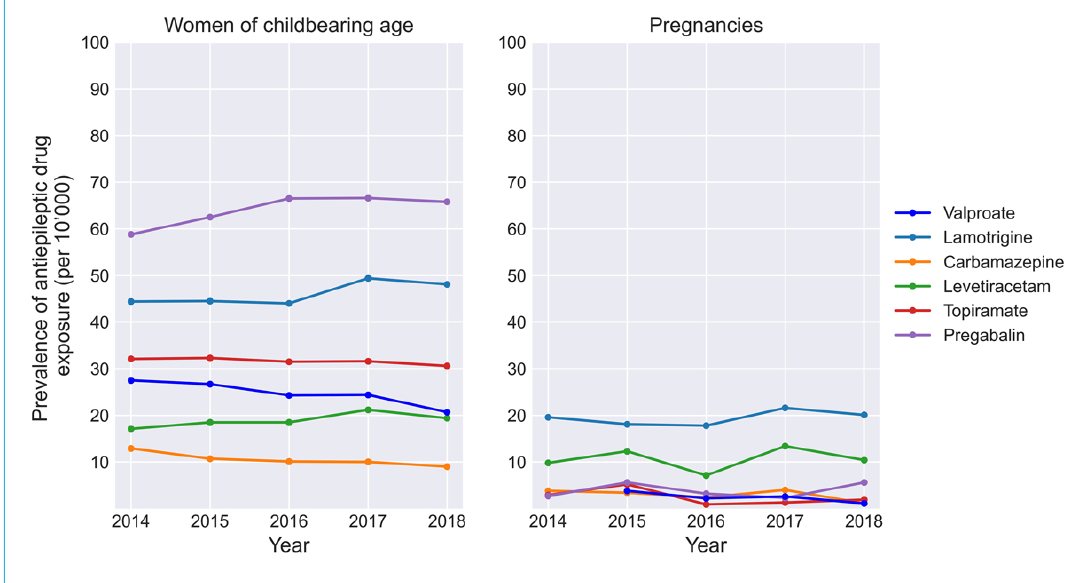
Figure 2: Prevalences of antiseizure drugs in pregnant women and women of childbearing age.